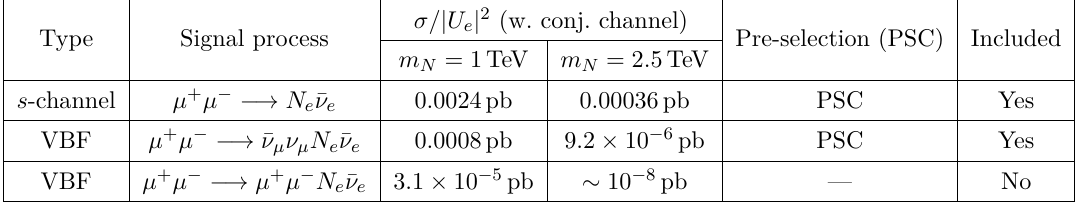
Table 5 . The signal rate for N e at 3 TeV muon collider. The pre-selection cut is defined as: p T ( ‘ − ) > 20 GeV and | η ( ‘ − ) | < 2 . 5 where ‘ − comes from N ‘ . The cross section includes the charge conjugate process.